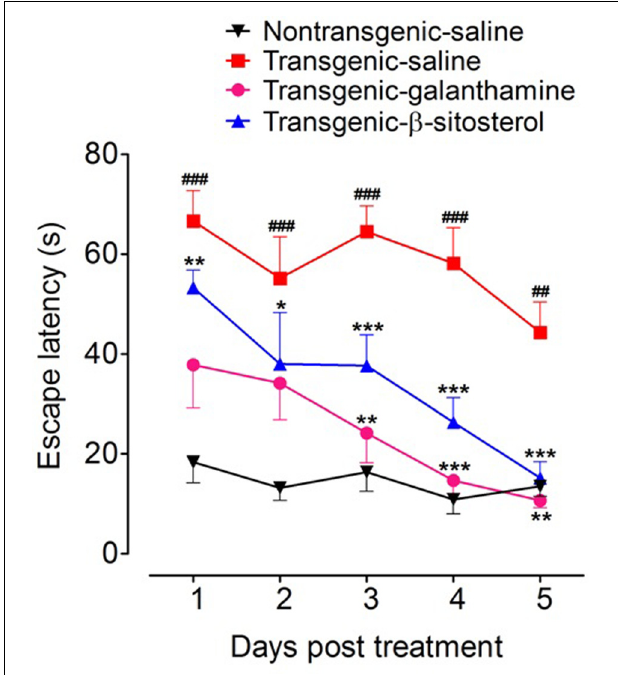
FIGURE 3 | Results of shallow water maze (SWM) test in different groups of animals; Non-transgenic-saline, Transgenic-saline, Transgenic- β -sitosterol and Transgenic-galanthamine. Symbols represent mean escape latency in s ± SEM. ## P < 0.01, ### P < 0.001 compared to non-transgenic normal controls, ∗ P < 0.05, ∗∗ P < 0.01, ∗∗∗ P < 0.001 compared to transgenic saline treated controls, two-way repeated measures ANOVA followed by post hoc Bonferroni’s